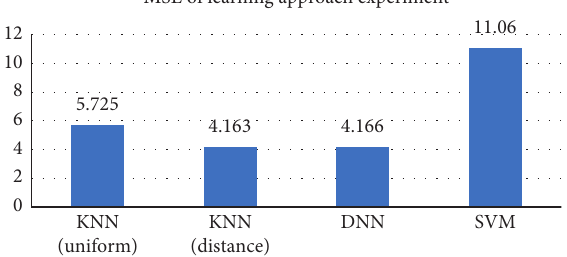
Figure 15: The comparison of average MSE scores in learning approaches for IPS